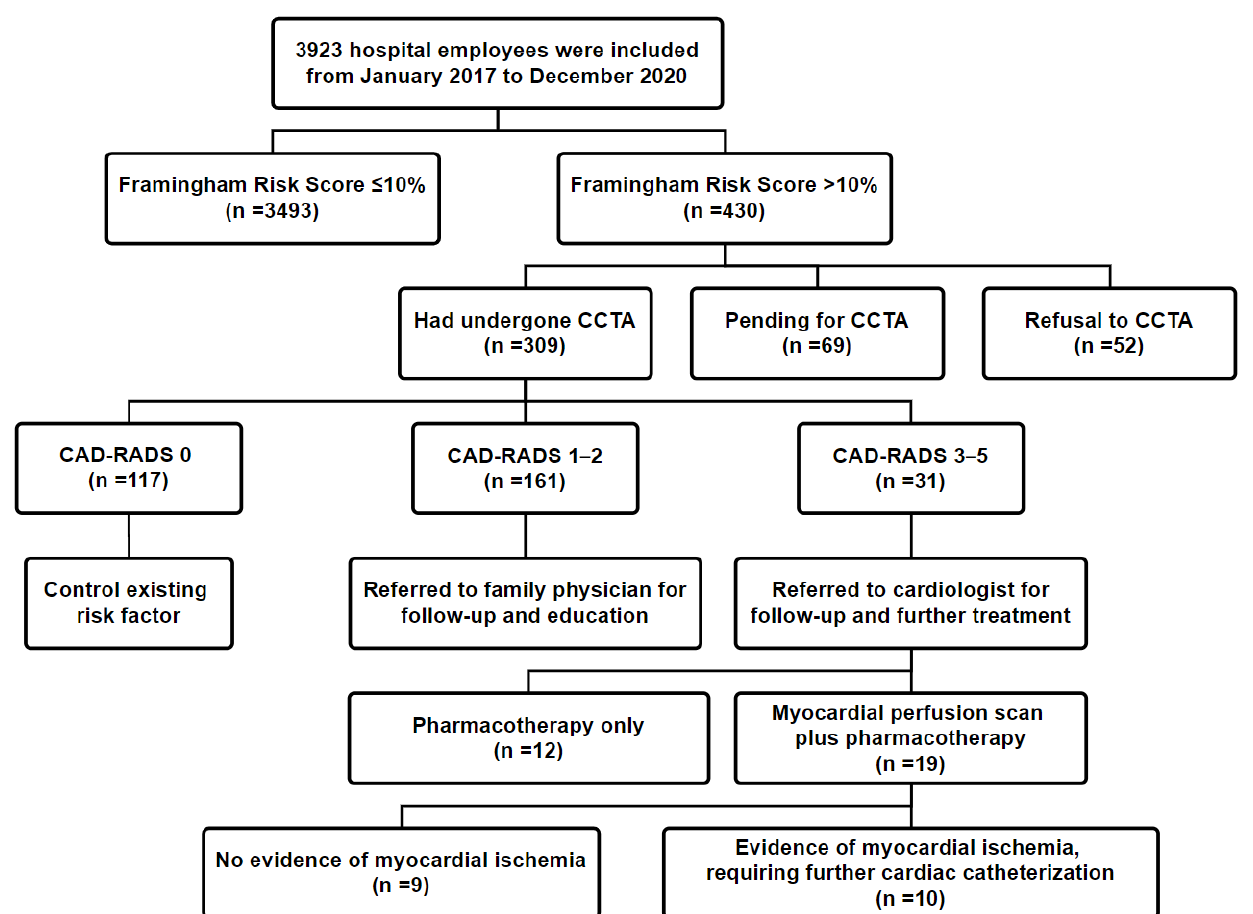
Figure 1. Flowchart for enrollment of the study population. Abbreviation: CCTA: coronary computed tomography angiography (CCTA); CAD-RADS: Coronary Artery Disease Reporting and Data System; PTCA: percutaneous transluminal coronary angioplasty.